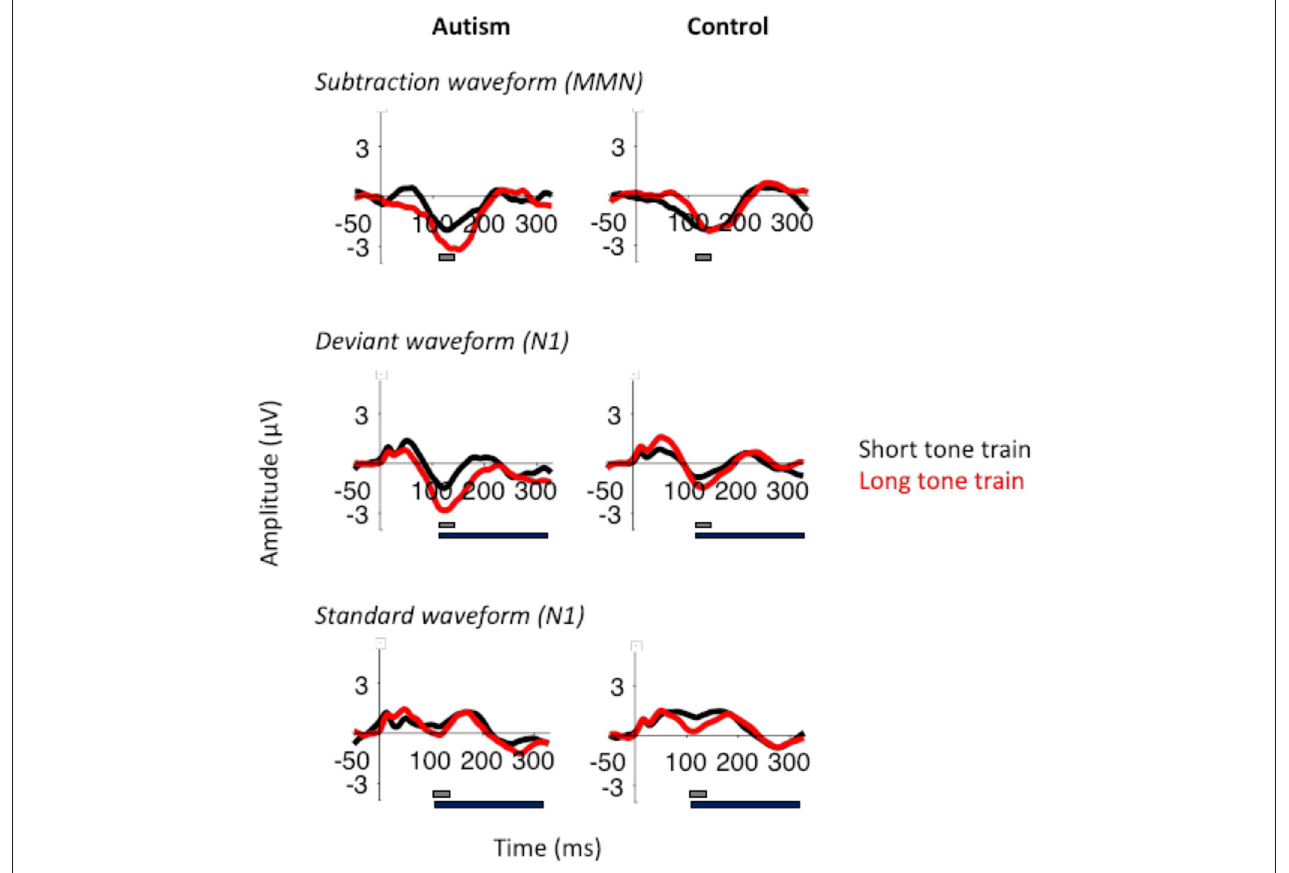
FIGURE 3 | MMN (top), deviant N1 (middle), and standard N1 (bottom) responses after the short tone train (black) and long tone train (red) for autism (left) and neurotypical controls (right). The gray bar indicates the window used for the peak amplitude analysis. The black bar indicates the window used for the TTV analysis. MMN was significantly larger after the long tone train in autism.